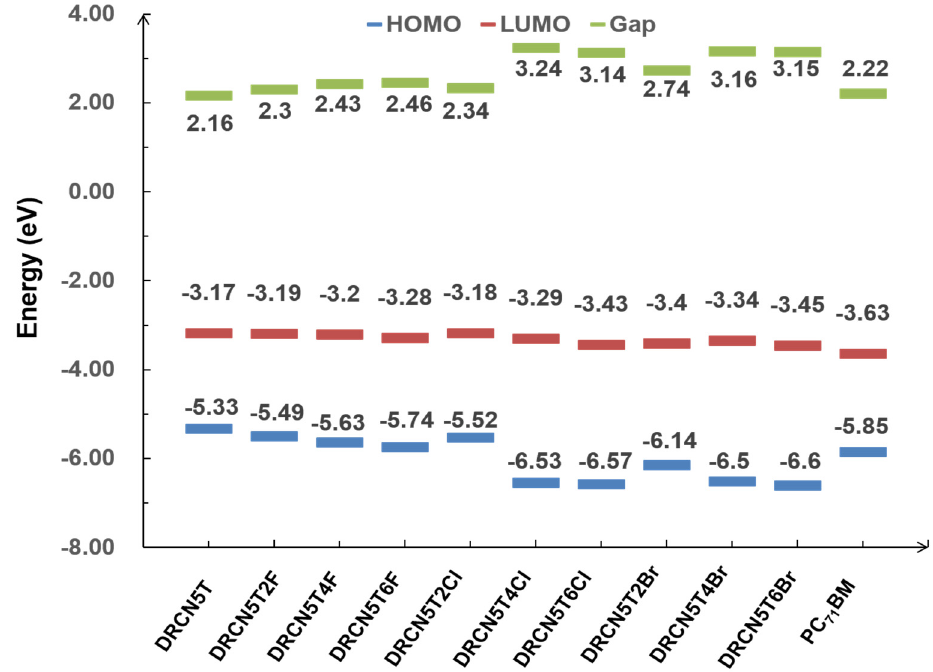
Figure 5. Calculated LUMO, HOMO and gap of DRCN5T, DRCN5T2F, DRCN5T4F, DRCN5T6F, DRCN5T2Cl, DRCN5T4Cl, DRCN5T6Cl, DRCN5T2Br, DRCN5T4Br, and DRCN5T6Br by using CAM-B3LYP/6 − 31+ G(d) in dichloromethane. Table 2. The predicted V OC of OSCs with DRCN5T and its derivatives as donor and PC 71 BM as acceptor via Equation (10). EA/IP correction denotes the absolute value of EA D, film -EA D, vacuum or IP D, film -IP D, vacuum , respectively. Unit: V for V OC ; eV for energy. Cor: Corrected; Exp: Experimental. In order to be consistent with the experimental value, we make corrections to all calculated V OC s, i.e., Cor V OC = V OC − 1.33 V, in which 1.33 V is the V OC deviation between experiment and calculation of DRCN5T/PC 71 BM